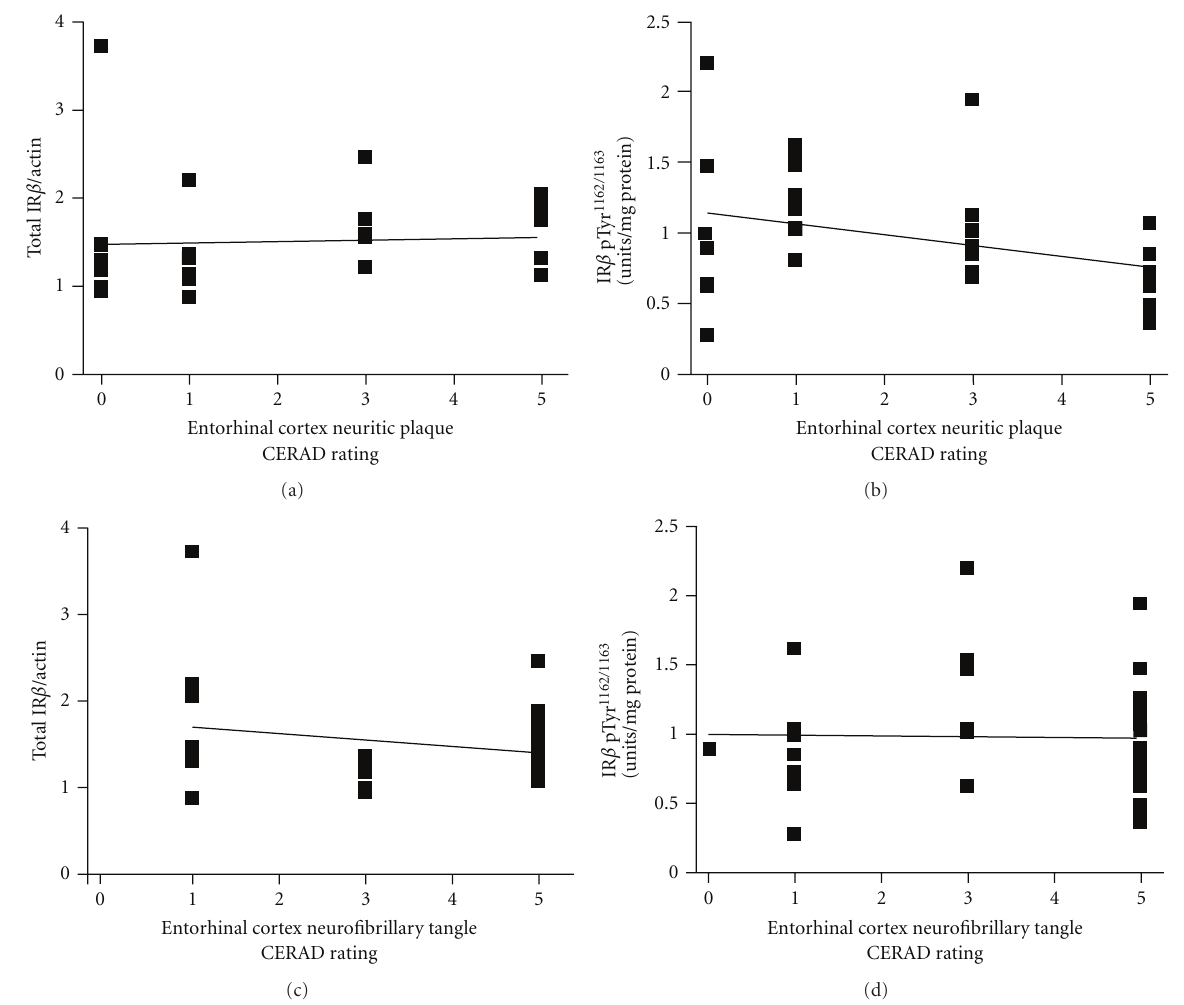
Figure 4: Total IR β and [Tyr1162/1163]-phosphorylated IR β contents in the brain are not correlated with the severity of AD-type neuropathology. AD-type neuritic plaque (NP) and neurofibrillary tangle (NFT) neuropathology were assessed using CERAD rating scales. In ((a) and (c)), correlation analysis of total IR β content with NP (a) and NFT (c) neuropathology in the brain. In ((b) and (d)), correlation analysis of [Tyr1162/1163]-phosphorylated IR β contents with NP (b) and NFT (d) neuropathology. In ((a)–(d)), solid line represents the best-fit correlation between IR β or [Tyr1162/1163]-phosphorylated IR β with NP or NFT neuropathology. Pearson correlation analysis; P = . 749 and .516 for IR β contents with NP and NFT neuropathology, respectively; P = . 283 and .912 for [Tyr1162/1163]-phosphorylated IR β contents with NP and NFT neuropathology,